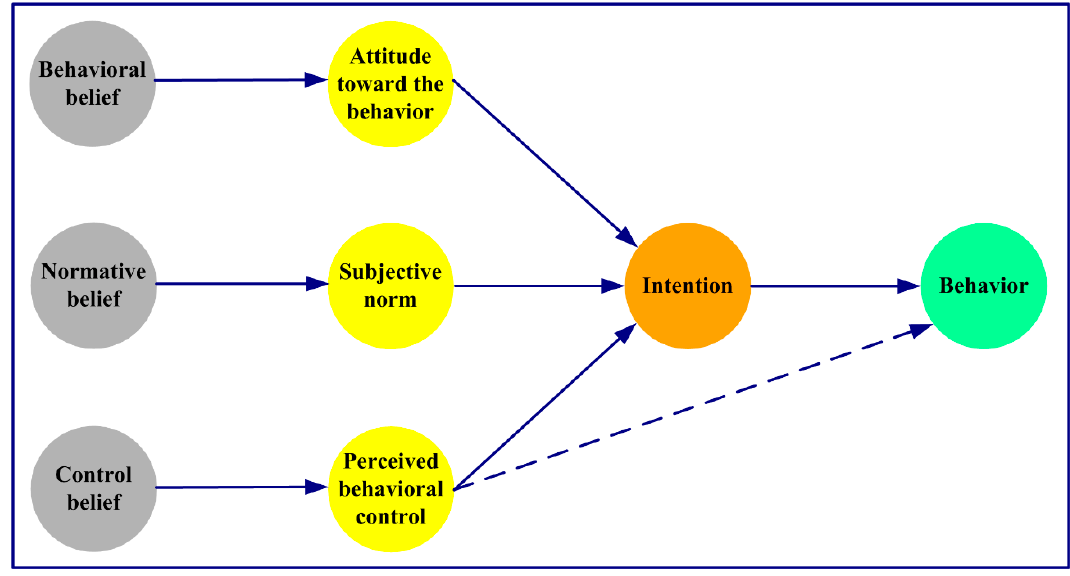
Figure 1. Theory of planned behavior.